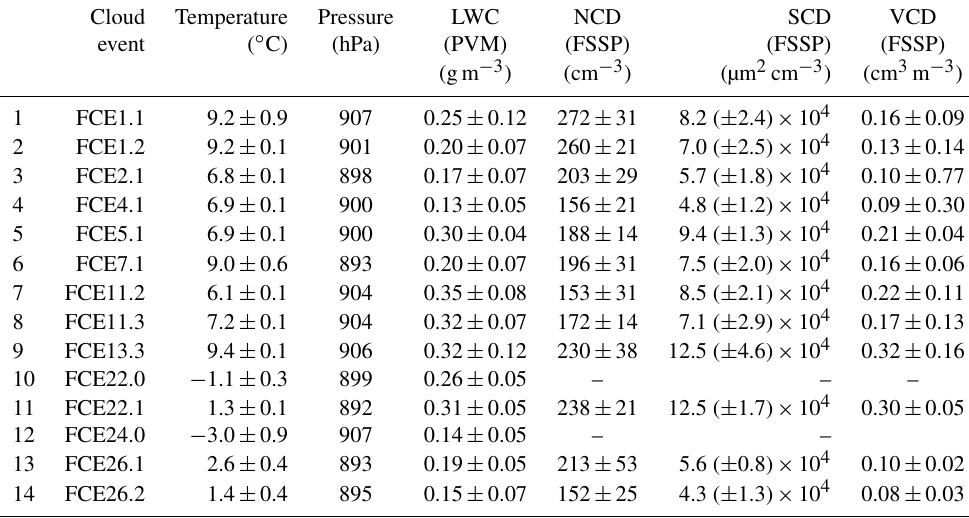
Table 2. Averaged meteorological parameters and cloud properties measured during the full cloud events, along with standard deviations. LWC: liquid water content, NCD: cloud droplet number concentration, SCD: cloud droplet surface concentration, VCD: cloud droplet volume